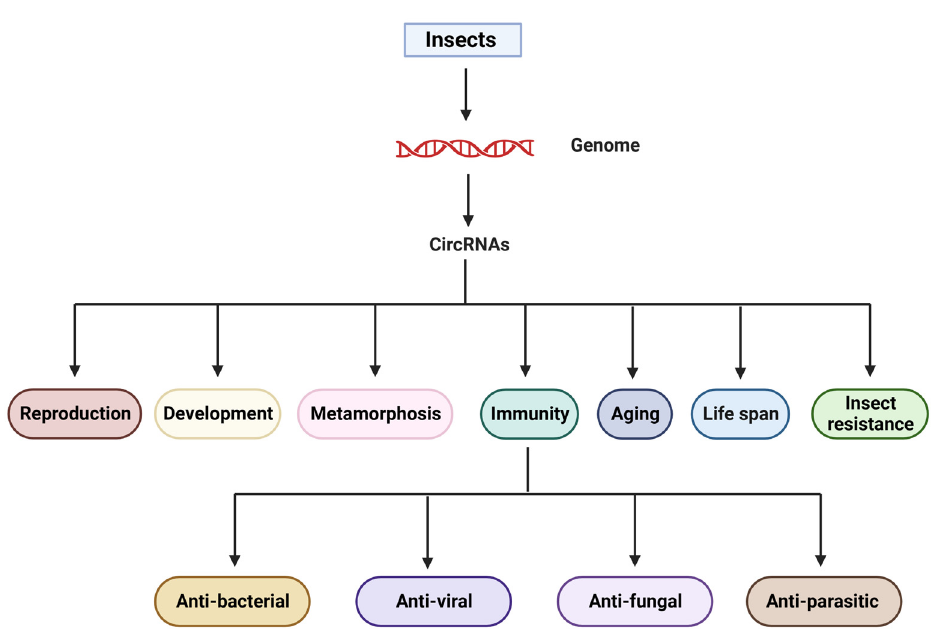
Figure 2. Overview of the biological role circular RNA plays in regulating various biological processes, in particular, immunity.